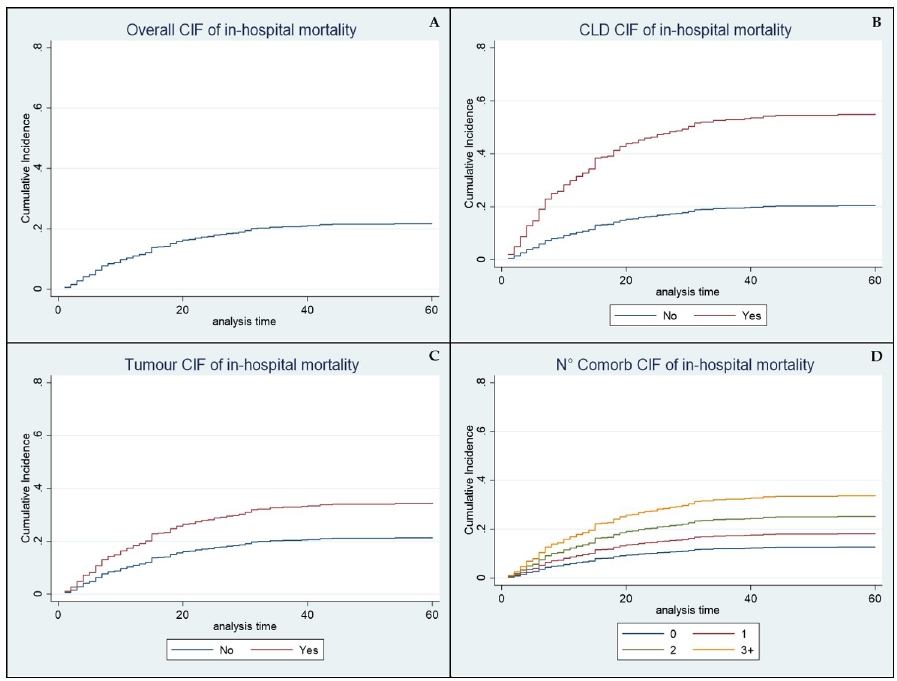
Fig 2. Cumulative incidence functions (CIFs) of overall comorbidities (Panel A), Chronic Liver Disease (Panel B), malignancies (Panel C) and number of coexisting comorbidities (Panel D).